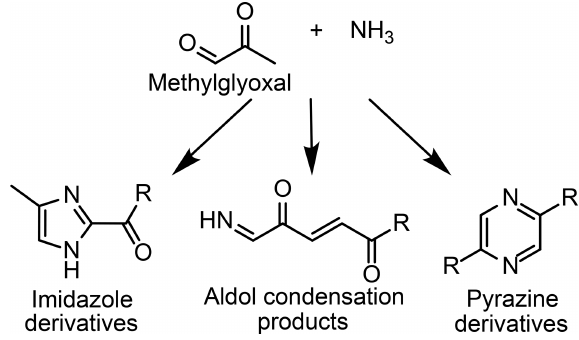
Figure 1. Methylglyoxal reacts with ammonia to form products with a variety of functional groups and